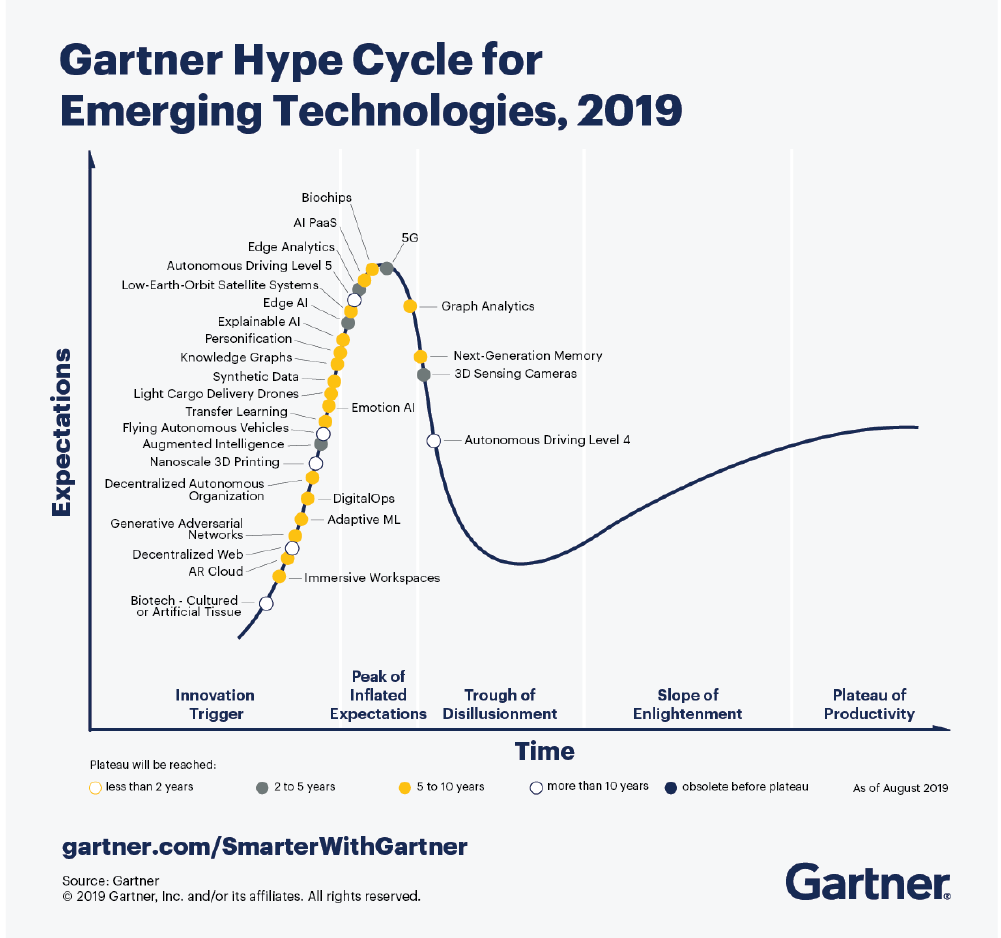
Figure 1. Gartner Hype Cycle for Emerging Technologies, 2019